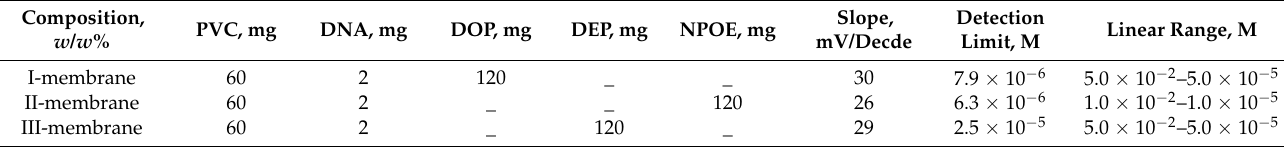
Table 2. Composition and performance characteristics of membrane types I and II used for Ca 2+ –DNA selective